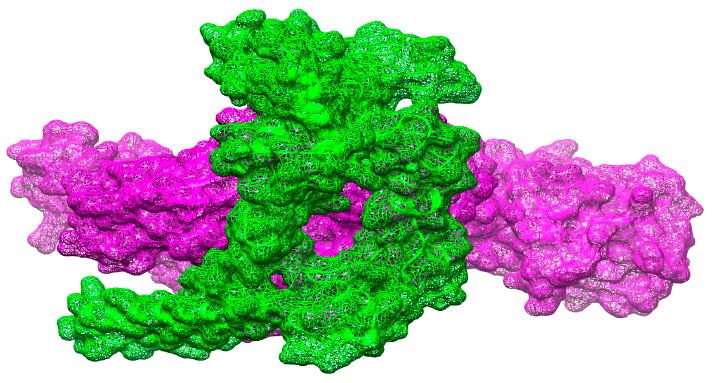
Figure 9. Docking of the vaccine to the MHC-I molecule. The green color shows the vaccine molecule while blue represents MHC-I.